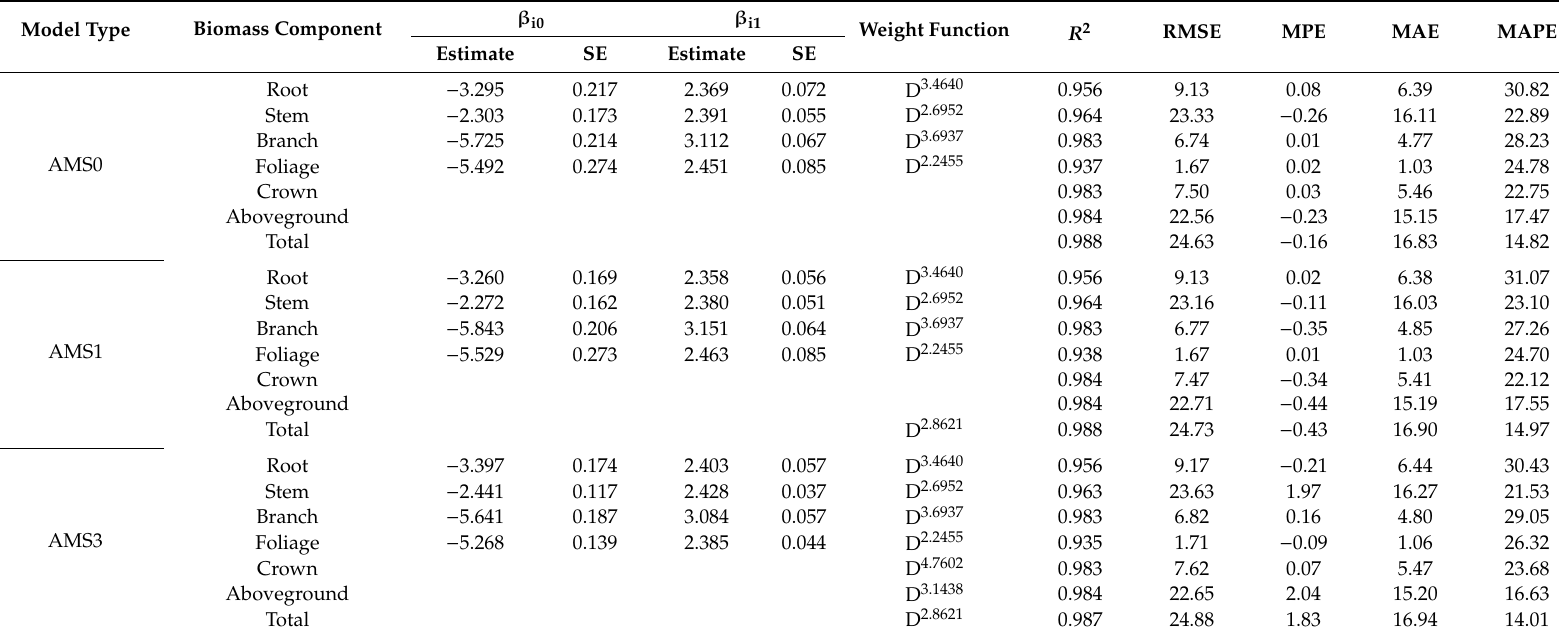
Table 4. Parameter estimates, standard errors (SE), model fitting statistics, weighting functions, and jackknifing validation for AMS0, AMS1, and AMS3 based on D